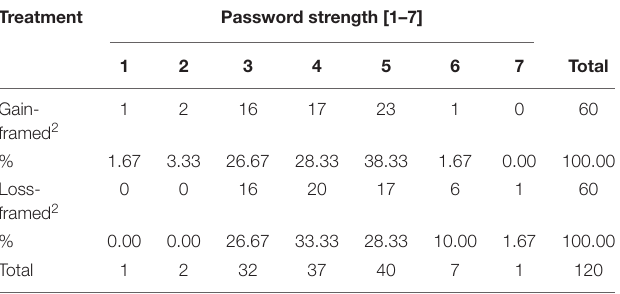
TABLE 4 | Decision 2 – choosing a strong password by treatment 1 . Treatment